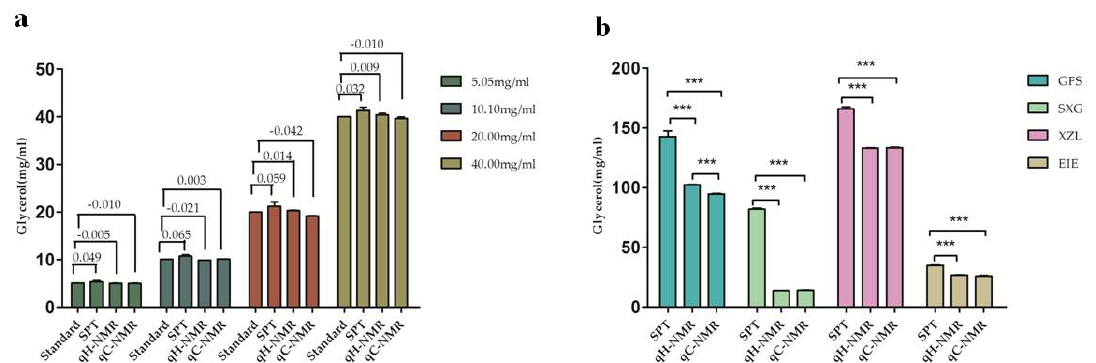
Figure 6. Clycerol contents determined by sodium periodate titration (SPR), 1 H NMR (qH-NMR) and 13 C NMR (qC-NMR) methods ( a ) in the homemade testing samples with glycerol at four concentrations (the relative errors were marks on the histograms); ( b ) in the injection samples, including glycerol fructose and sodium chloride injection (GFS), Shenxiong glucose injection (SXG), Xiaozhiling injection (XZL), and etomidate injectable emulsion (EIE). *** p < 0.001.